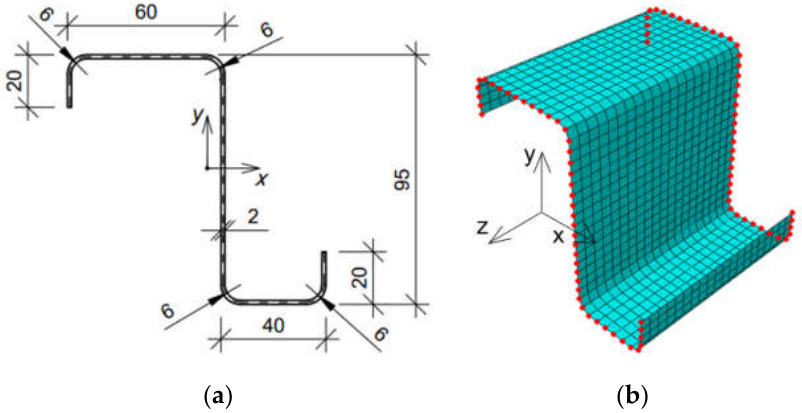
Figure 2. Z profile considered: ( a ) cross-section (units in mm); ( b ) finite element mesh with condensed nodes selected for a 100 mm case.